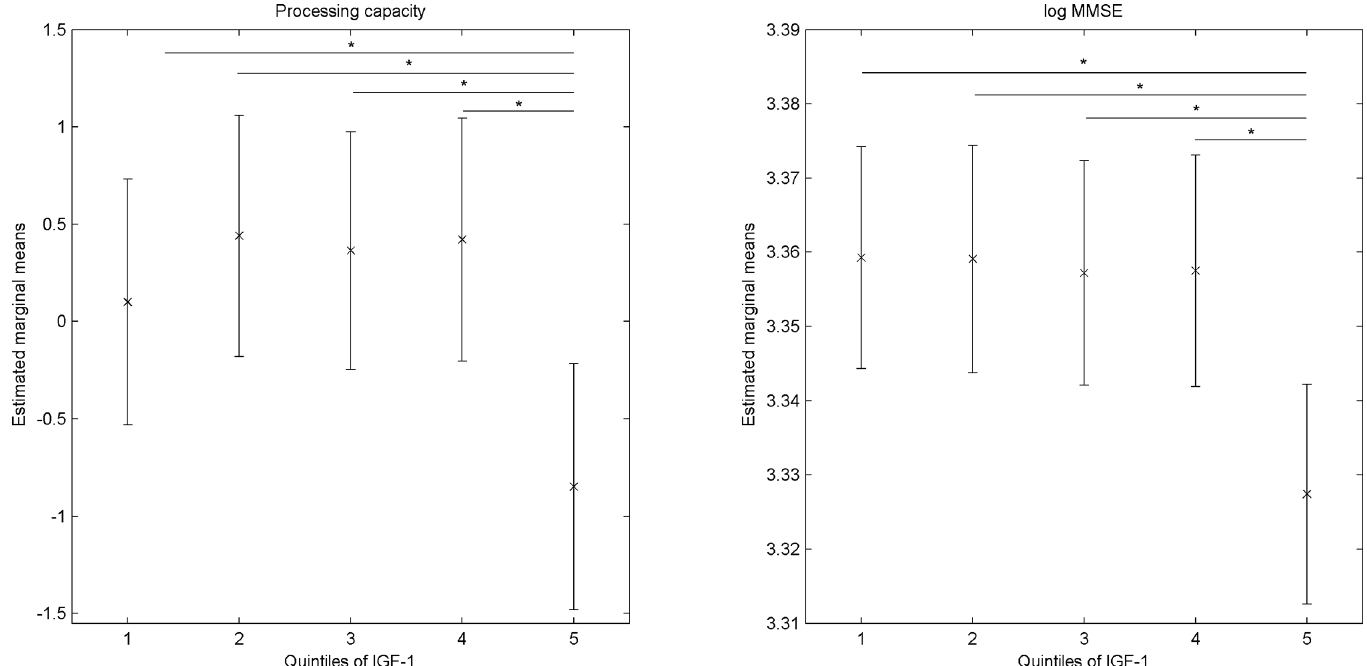
Fig 1. Mean performance in cognitive domains at follow-up for quintiles of IGF-1 in complete case dataset (adjusted for cognitive scores at baseline, age, education level, BMI, smoking, physical activity, and glucose levels. Error bars indicate 95% confidence intervals of the adjusted mean cognitive score. Higher values on y-axis represent better cognitive performance. Sample size in each quintile: Q1 = 53, Q2 = 53, Q3 = 56, Q4 = 52, Q5 = 51. * indicates significant at a p value of <